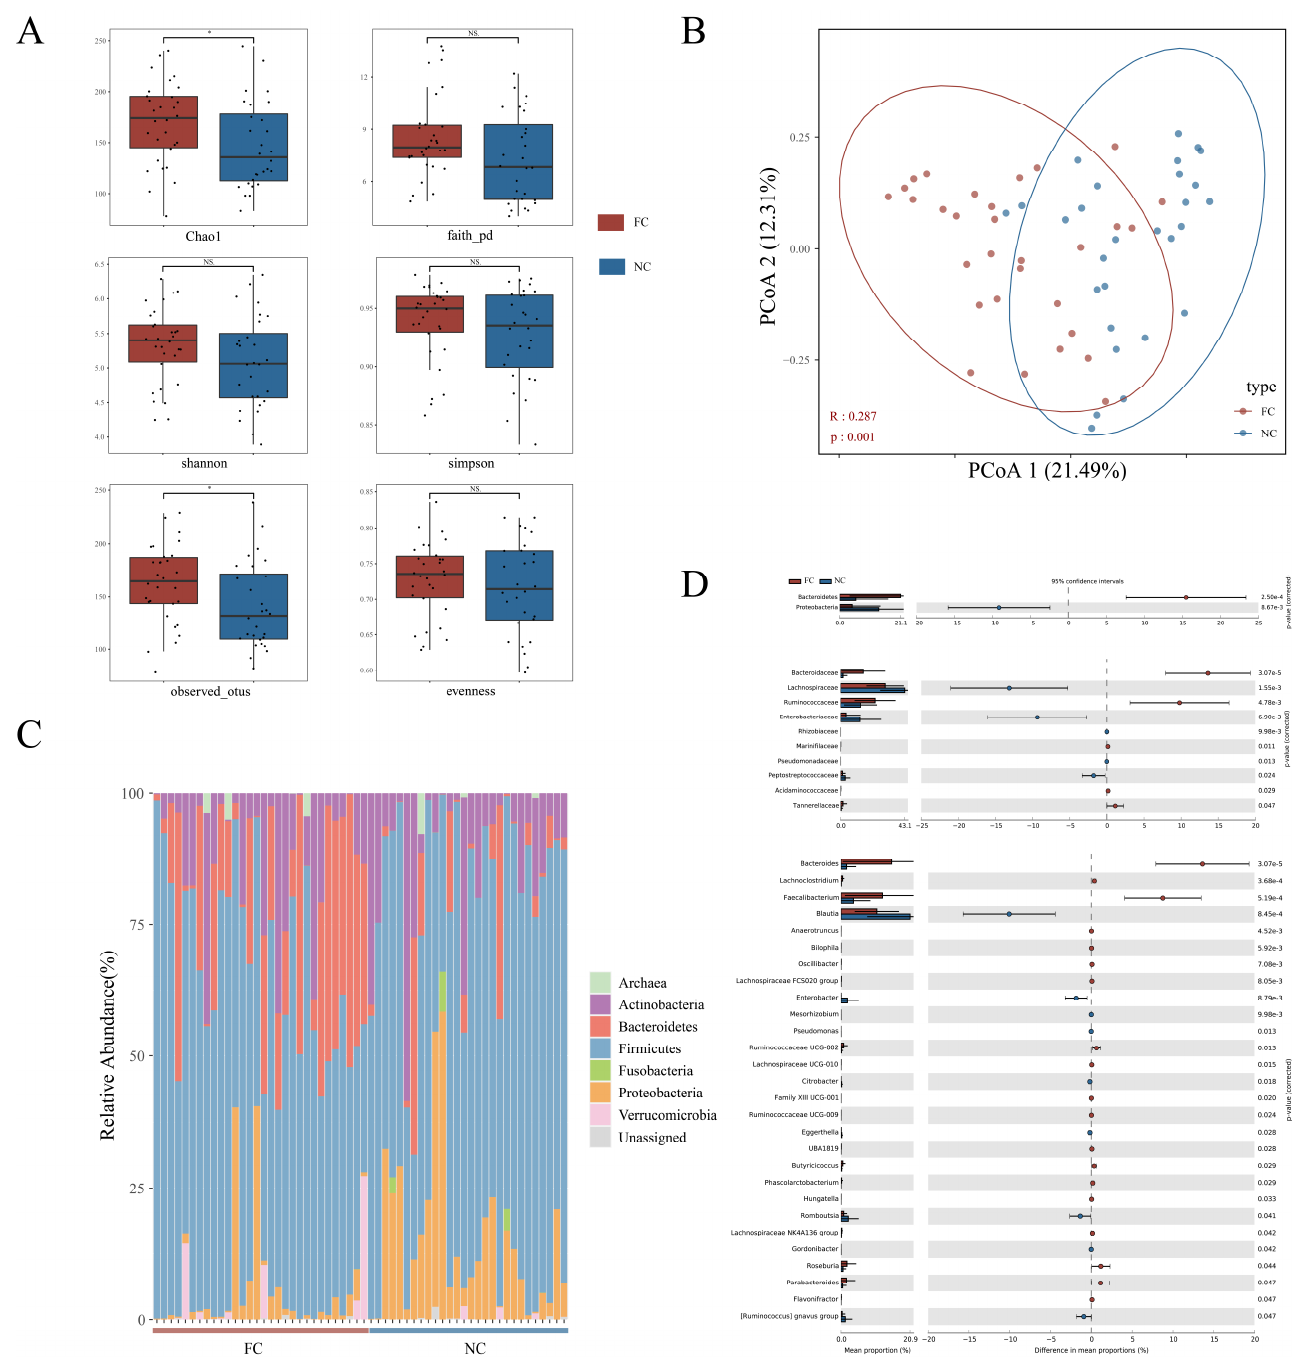
Figure 1. Intestinal microbiota community structure. ( A ) boxplot of six α-diversity indexes. ( B ) PCoA plot of β-diversity shows the differences between samples or groups. The horizontal and vertical axes are the two main coordinates with the greatest degree of explanation for the largest sample. ( C ) Stacked histogram shows the relative abundance of each individual’s gut microbes at the phylum level. ( D ) Differential microbes of the FC and NC groups at the phylum, family, and genus levels. * p < 0.05, NS p ≥ 0.05.